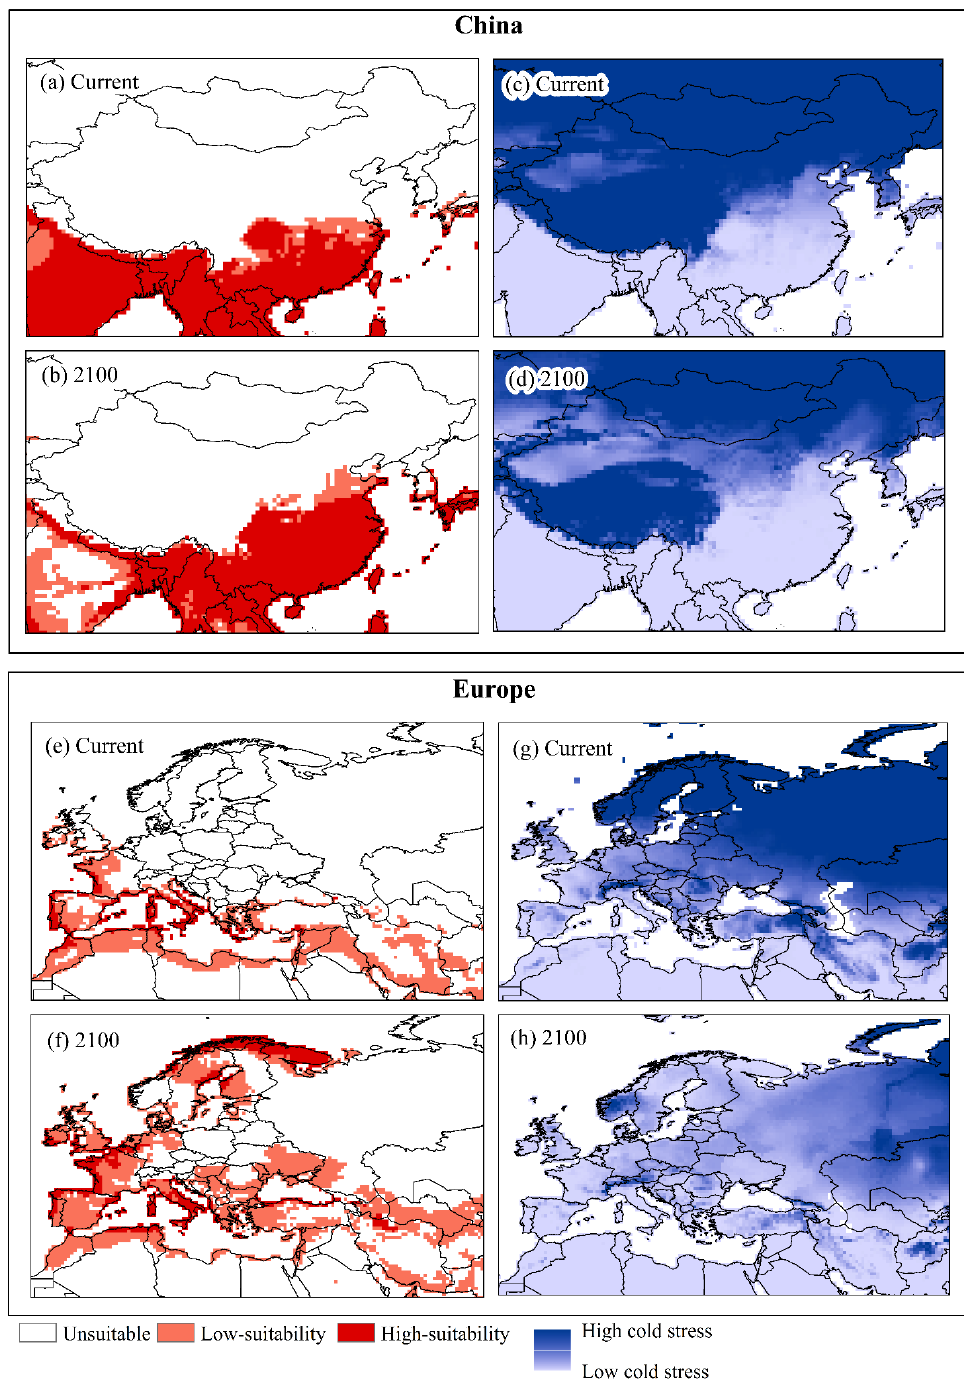
Figure 6. Current and projected Ecoclimatic Index (EI) ( a , b , e , f ) and cold stress patterns ( c , d , g , h ) using CLIMEX under CSIRO SRES A2 scenario for U. panicoides for China and Europe. Unsuitable areas in white (EI = 0), low-suitability areas in light red (0 < EI < 30), and high-suitability areas in red (30 < EI <